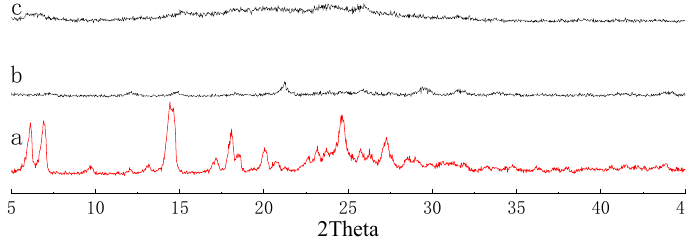
Figure 6. PXRD patterns of ( a ) TFFPy, ( b ) CMP − shu − 1, ( c ) CMP − shu − 2.